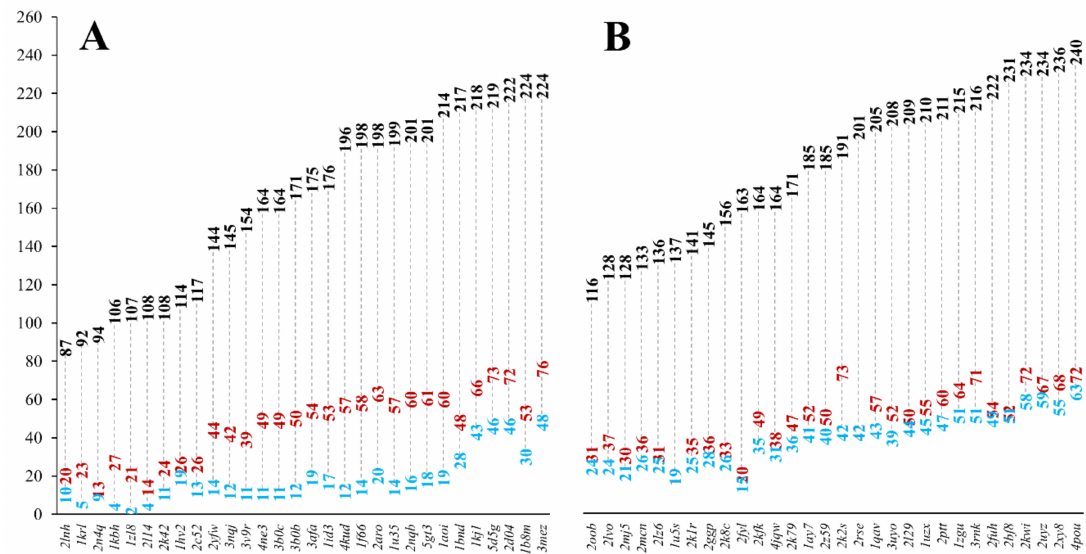
Figure 3. The number of burial residues in MFHE ( A ) and GLHE ( B ) complexes (black: number of all residues in a complex, red: number of buried residues in a heterodimeric complex, blue: sum of numbers of buried residues in the two monomeric subunits. See Figure S1 for the number of buried residues for the homodimeric MFHO and GLHO